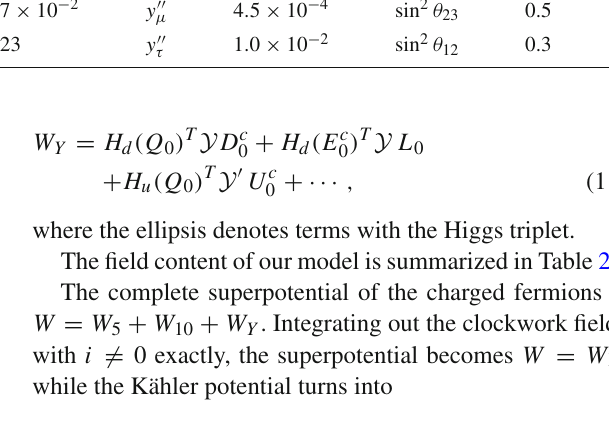
= y β and y (cid:4)(cid:4) = y β . The values are representative, as they i sin i cos i i